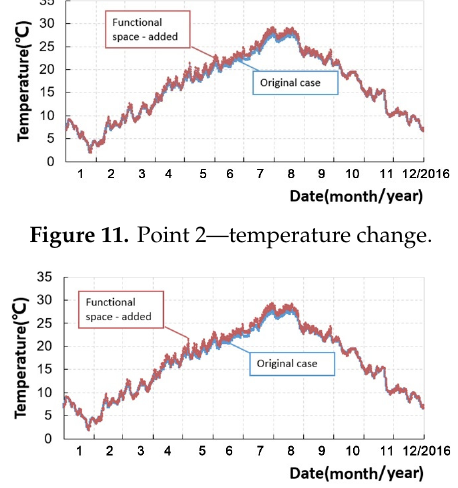
Figure 12. Point 3—temperature change .